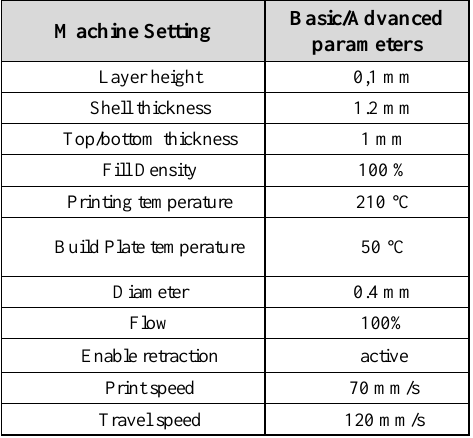
Table 3. Setting print parameters.